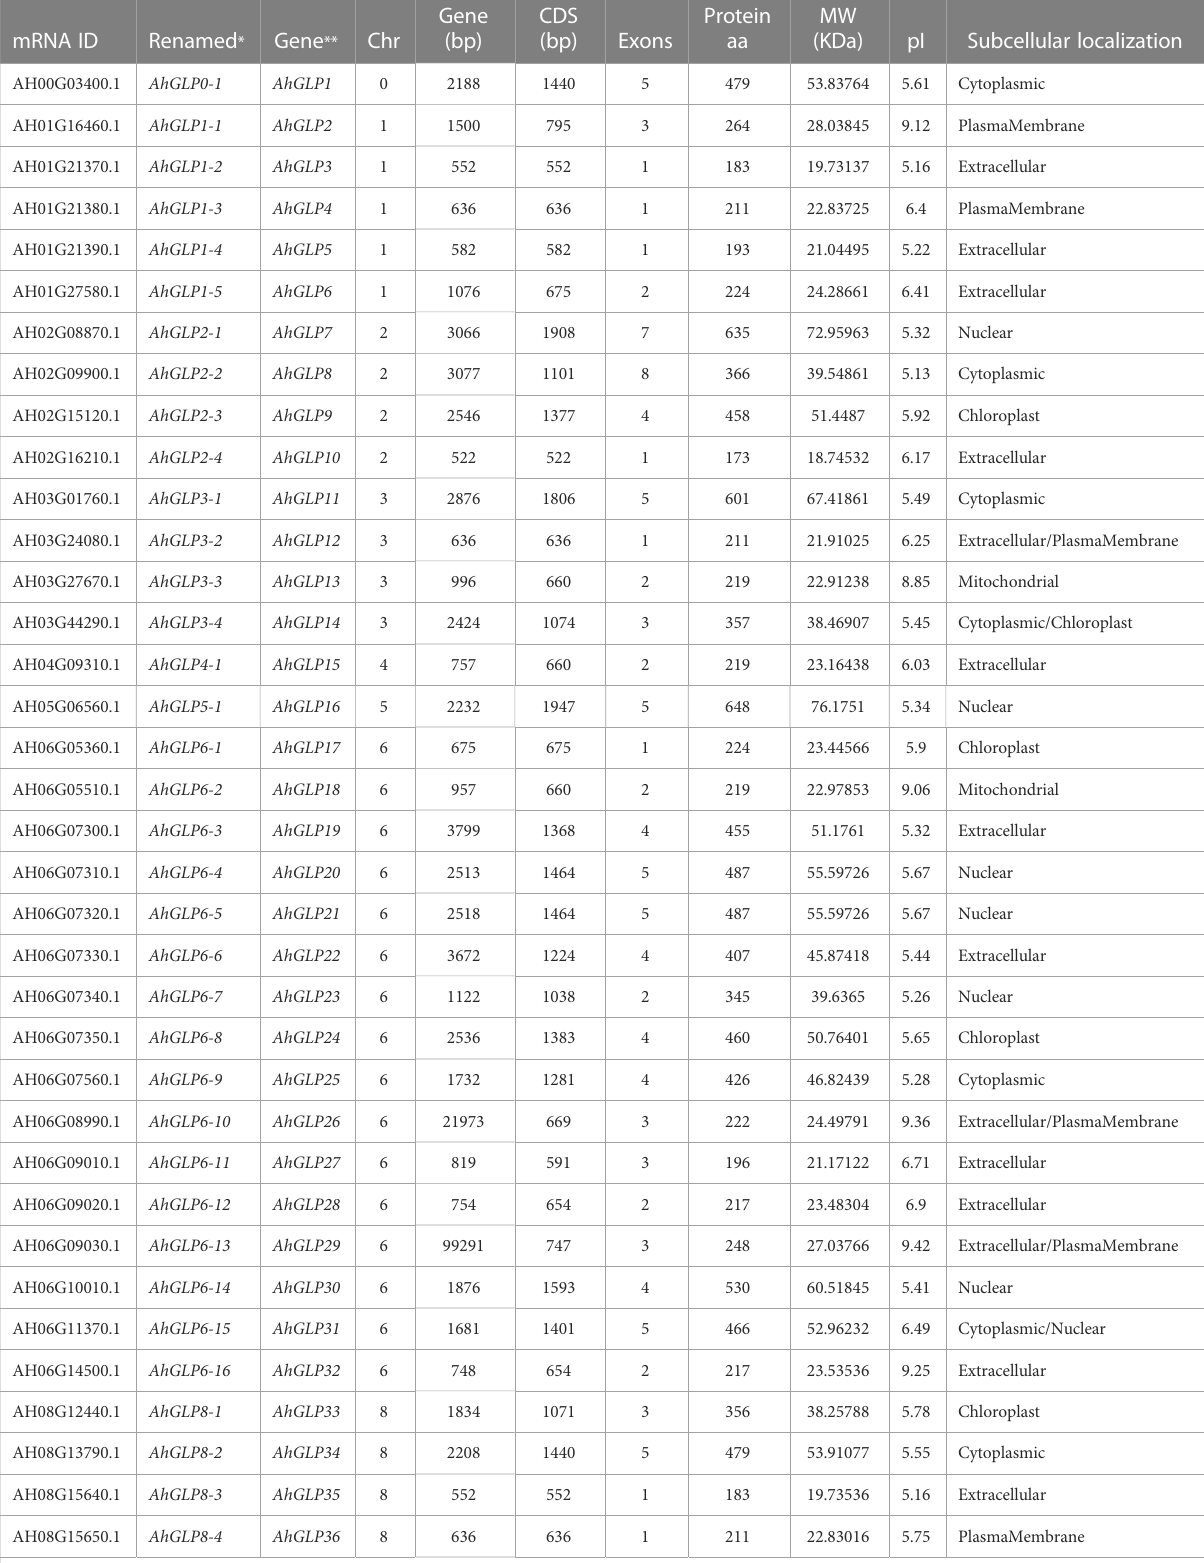
TABLE 1 Germin-like protein members in Arachis hypogaea and their physicochemical properties.